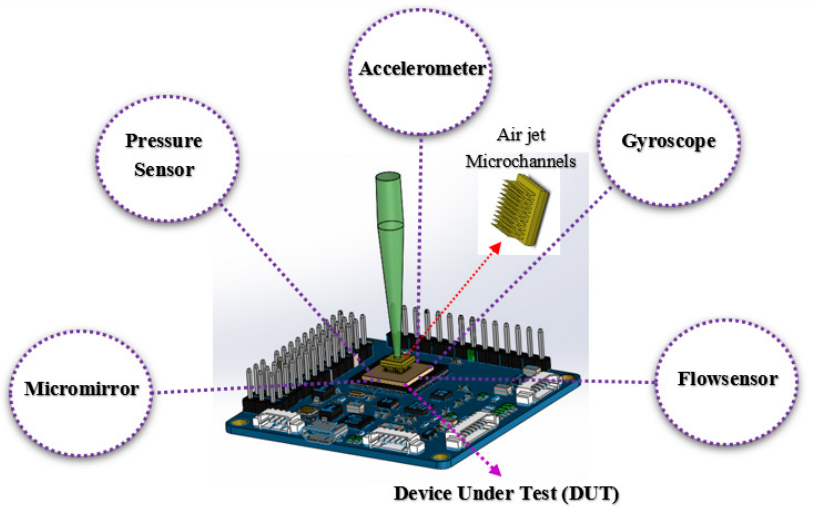
Figure 1. The operational concept of Airflow-based Force Manipulation (AbFM) and its potential market for MEMS testing and characterization. AbFM can be used to apply gas shear stress on the proof mass of accelerometers and gyroscopes or their comb drives vertically or tangentially to stimulate motion. In pressure sensors, it can manipulate the diaphragm, cantilevers, or any sensing elements. Airflow can be applied to micromirrors to make a motion and to evaluate the structures. To test flow sensors, it can apply fluidic force or thermal actuation through differing flow temperatures to test both mechanical and thermal flow sensors.